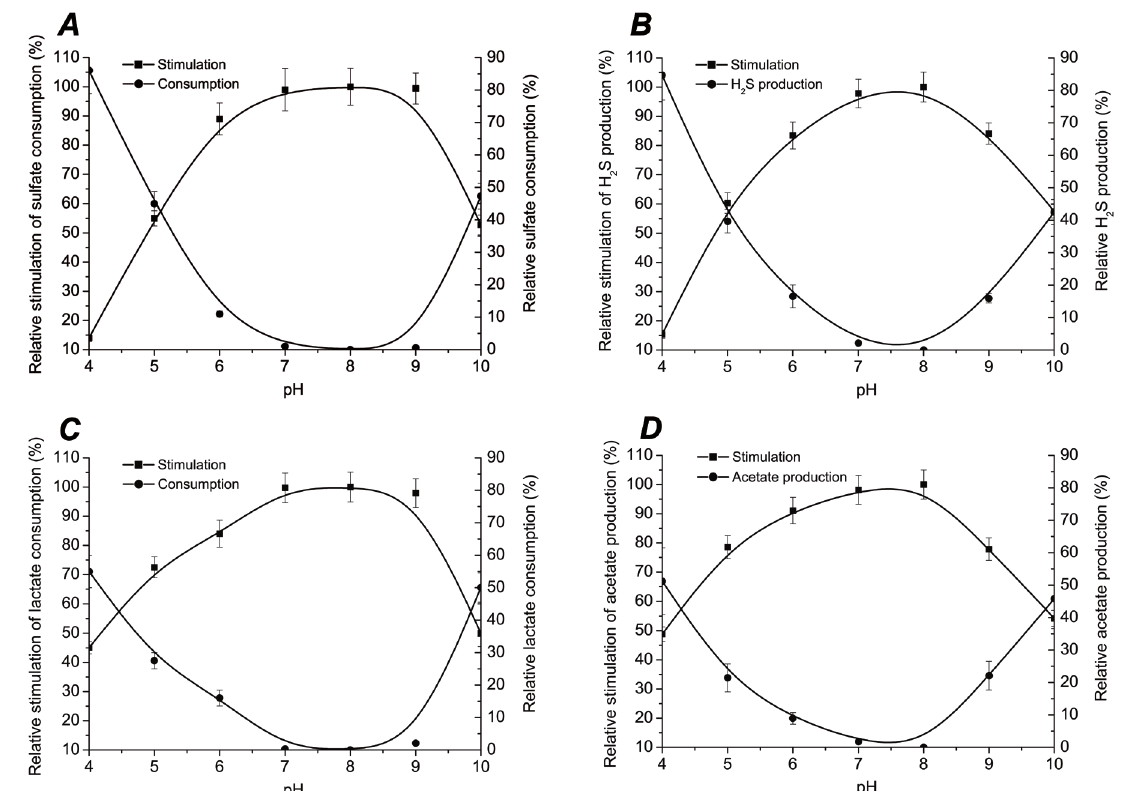
Figure 2 : Relative pH for sulfate reduction parameters: sulfate consumption ( A ), hydrogen sulfide production ( B ), lactate consumption ( C ), and acetate production ( D